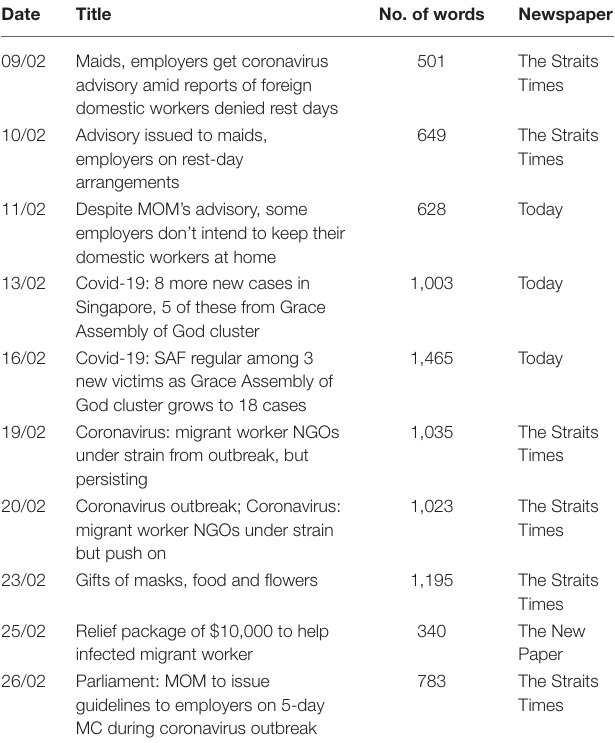
TABLE A1 | Illustration of newspaper articles and